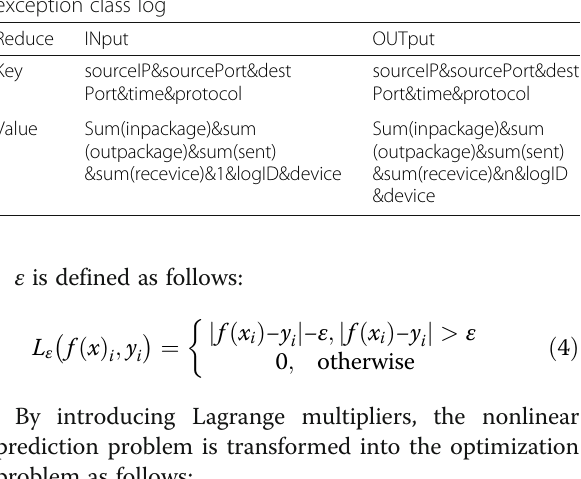
Table 6 The Reduce phase input and output of the attack